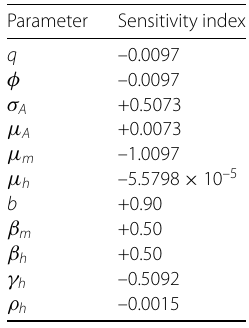
Table 2 Sensitivity indices of R 0 evaluated at the baseline parameter values for α = 0.9